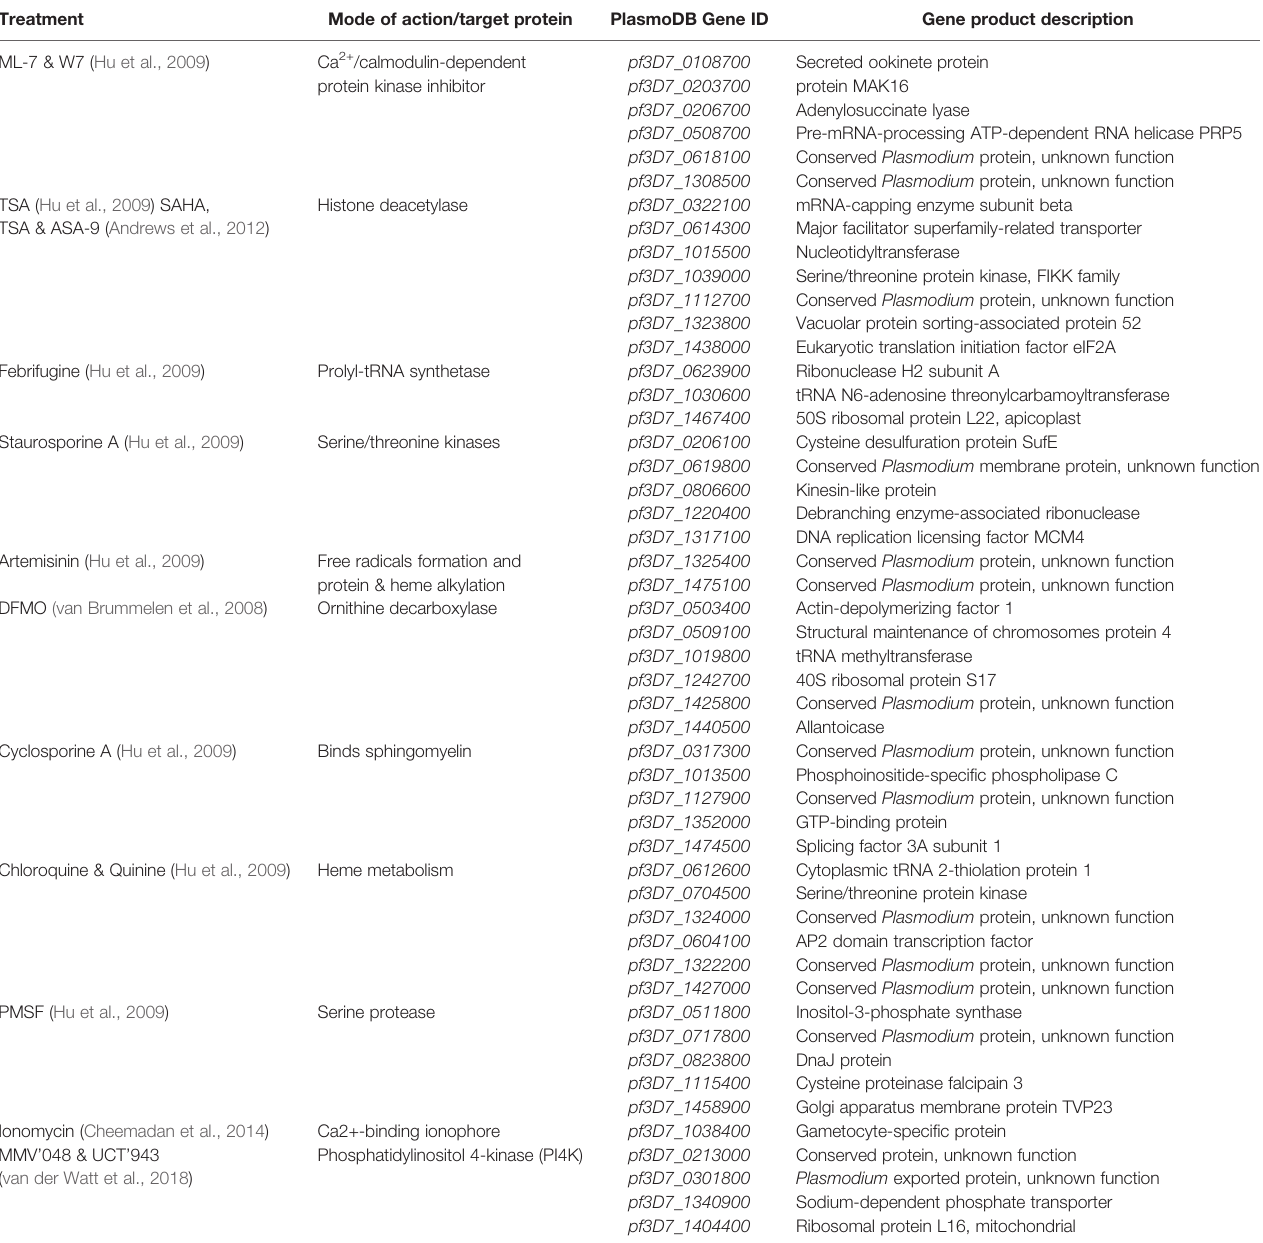
TABLE 1 | The top 50 biomarkers identi fi ed from the ML modeling. Treatment Mode of action/target